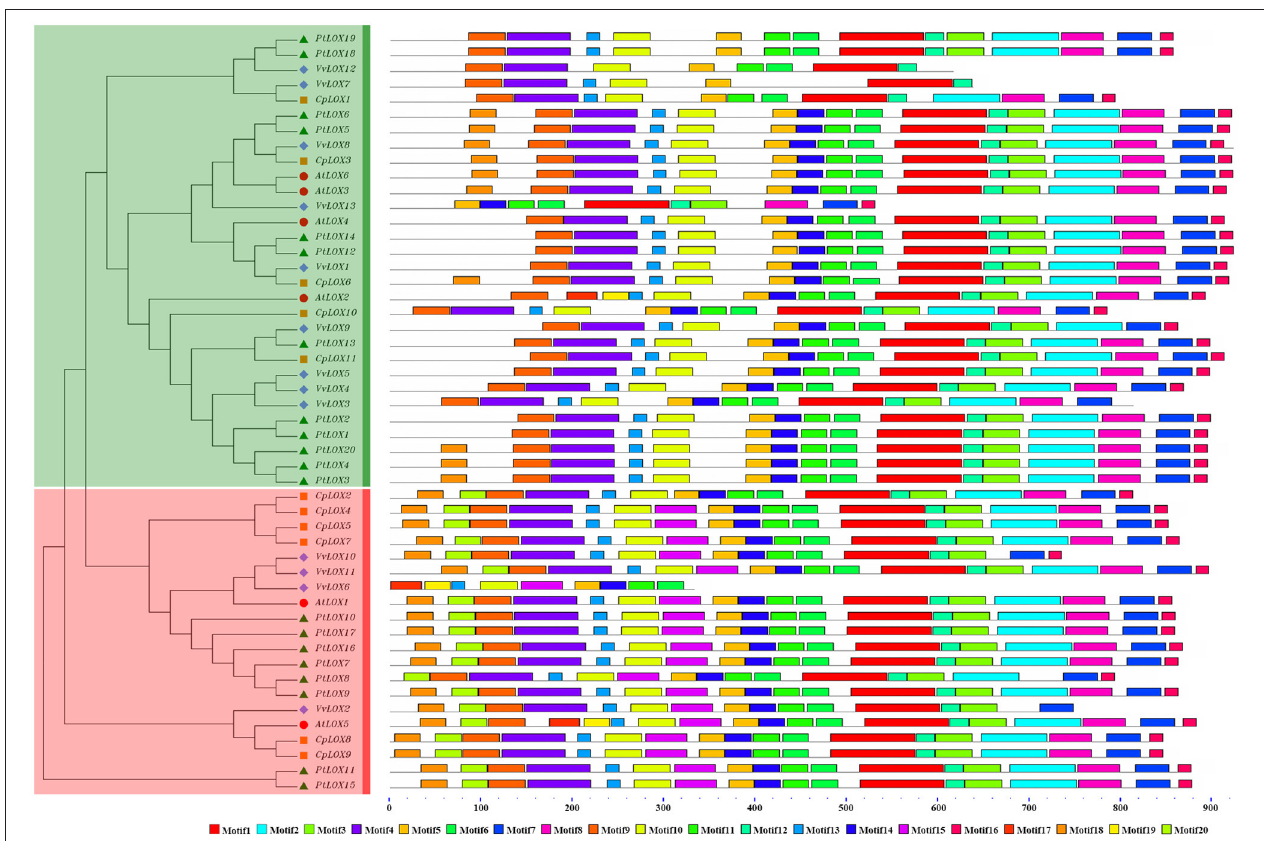
FIGURE 3 | Distribution of conserved motifs in the LOX family members. All motifs were identified by MEME using the complete amino acid sequences of 50 LOX proteins of four rosid plants. Sub-families of LOX genes are highlighted with different colored backgrounds, red for 9-LOX sub-family and green for 13-LOX sub-family. The different colored boxes represent different motifs and their position in each LOX sequence. For details of the motifs see Supplementary Table